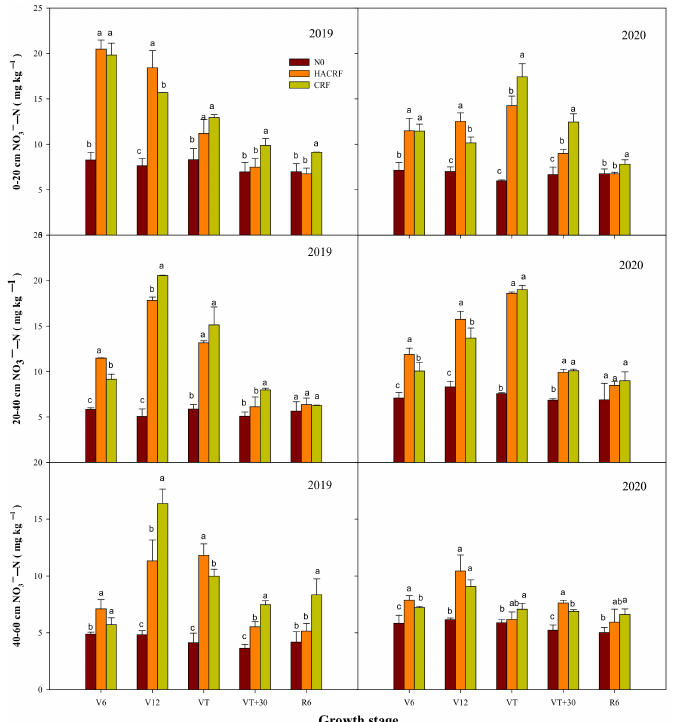
Figure 3. Effects of humic acid added to controlled-release fertilizer on NO 3 − -N during summer maize growth stage. N0: without N fertilizer; CRF: controlled-release fertilizer; HACRF: adding humic acid to controlled-release fertilizer. Different letters in each column indicate significant differences at p < 0.05